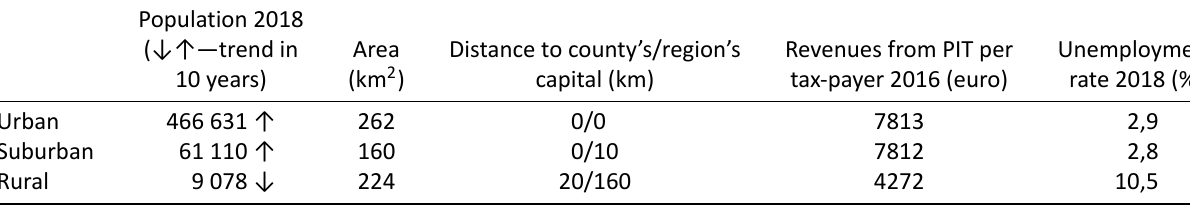
Table 2. Basic background data on case